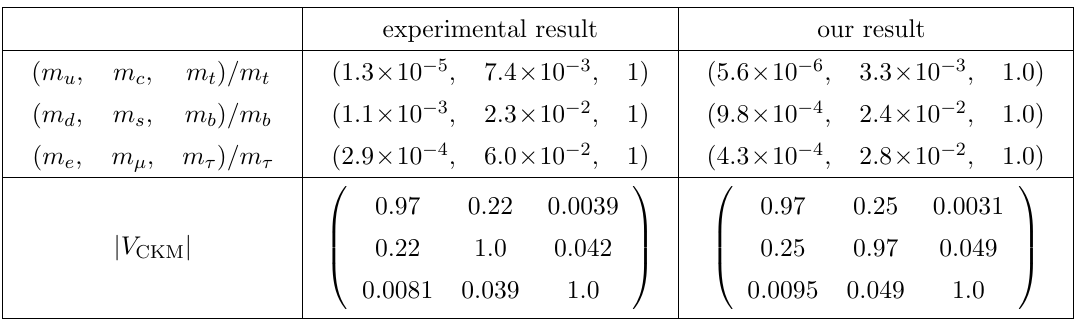
Table 4 . The fermion mass and mixing angle for the assignment No.77. The experimental values given in